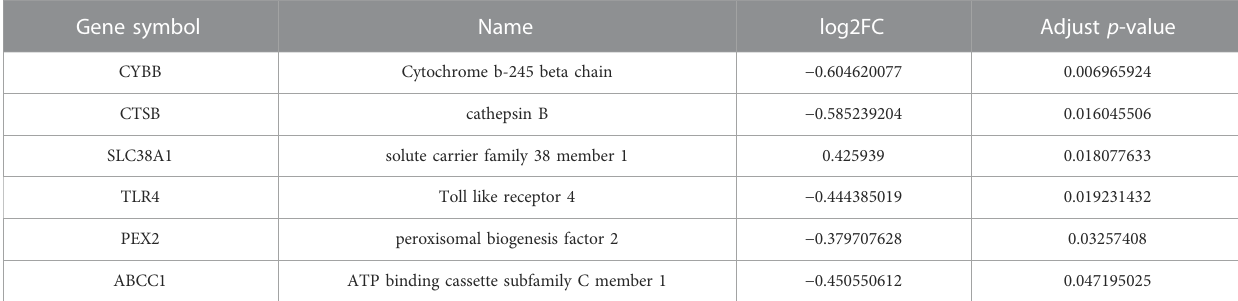
TABLE 1 Six differentially expressed FRGs.